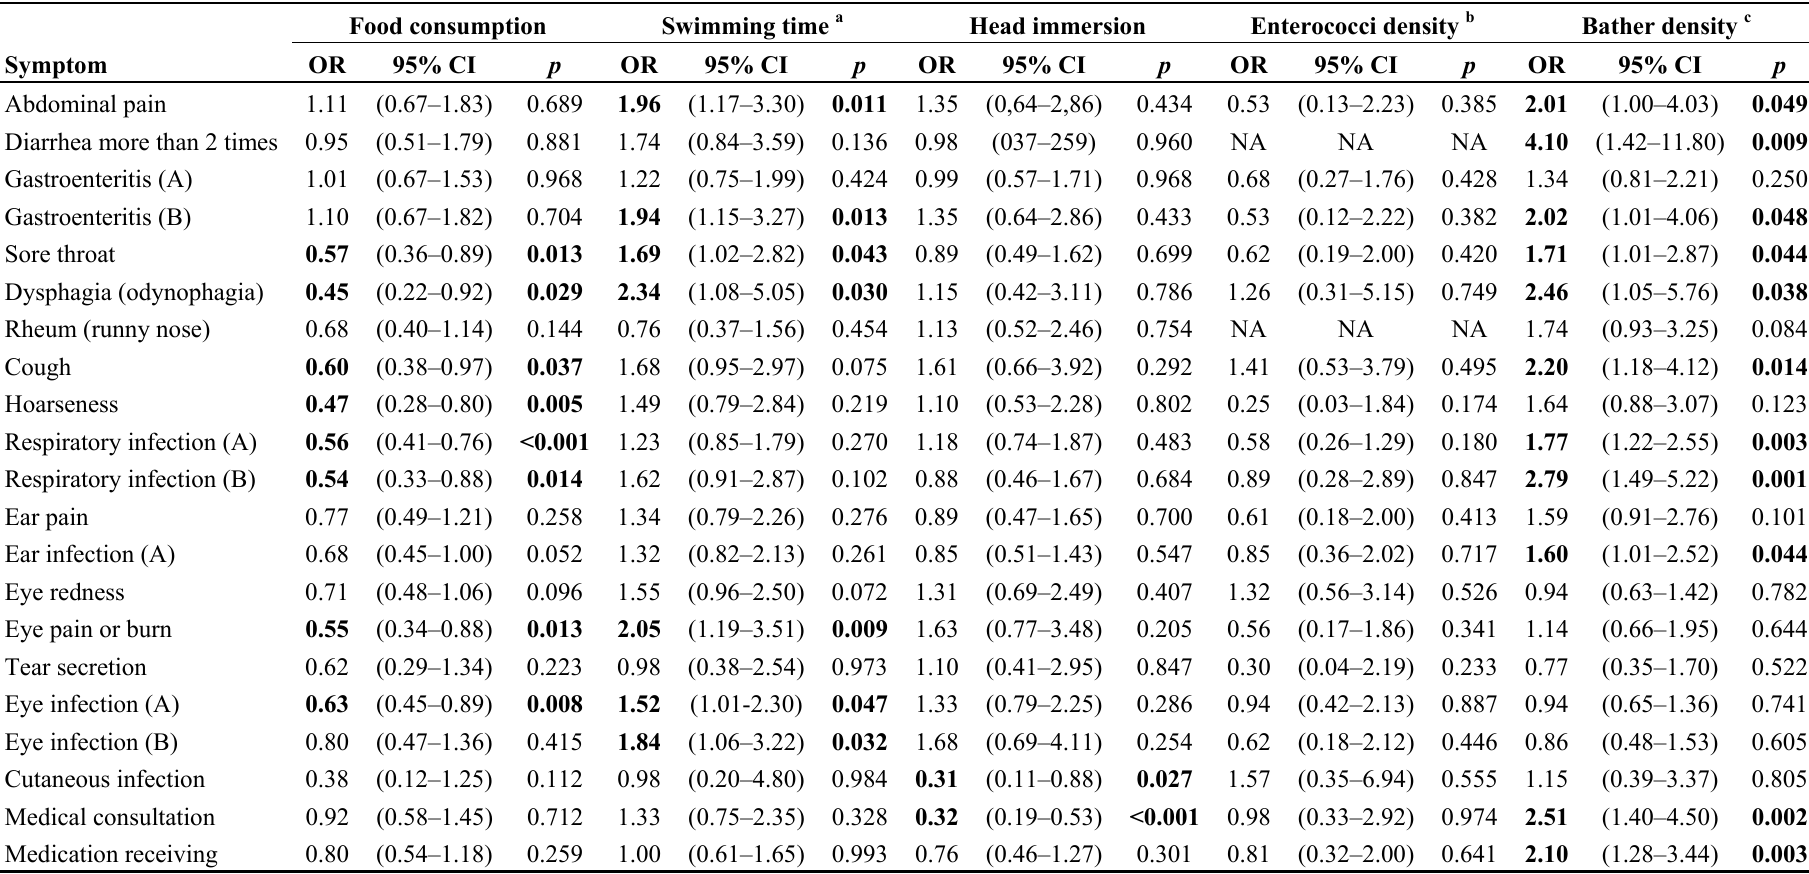
Table 5. Association of symptoms and related exposures only for bathers (multivariable